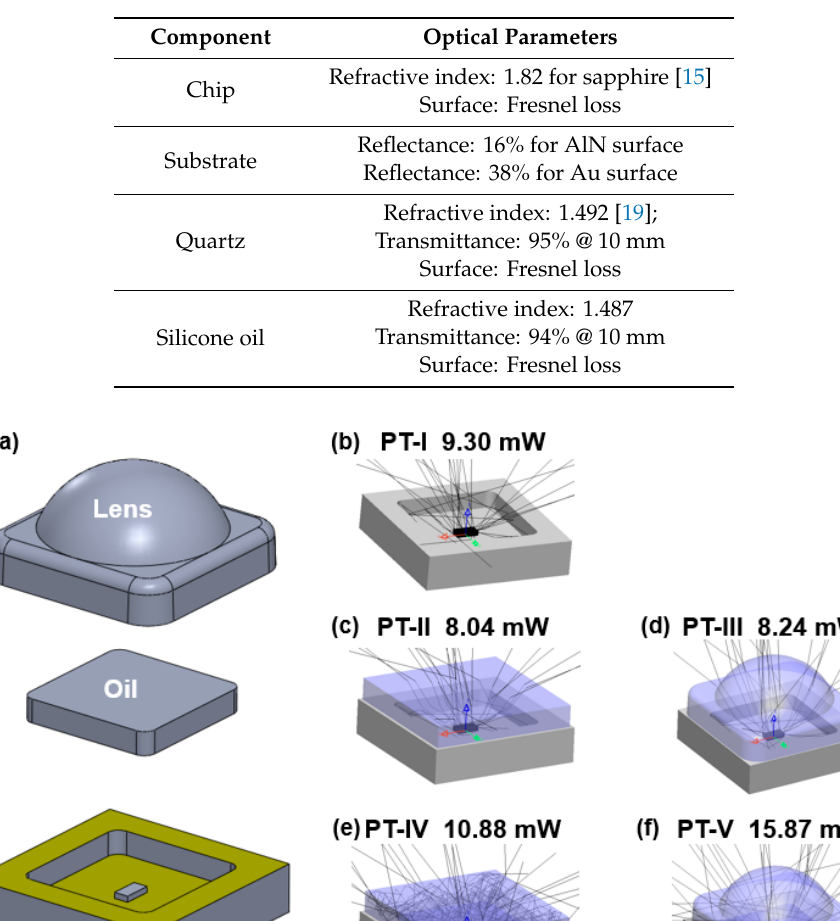
Table 1. Optical parameters of the components of the proposed DUV-LED.